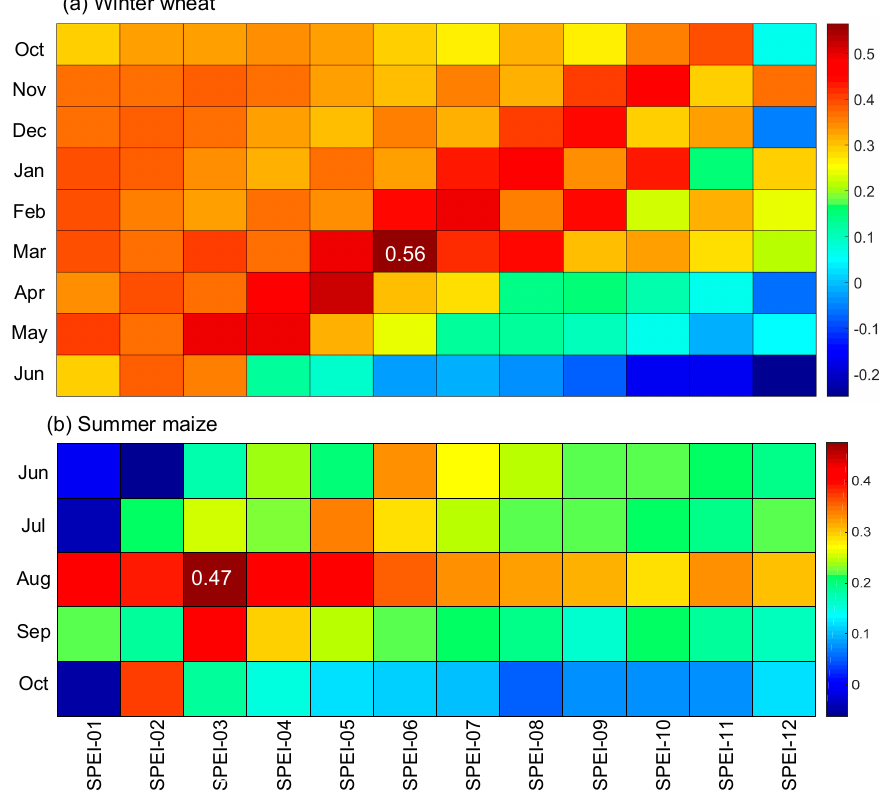
Figure 6. Spearman’s correlation coefficients ( r) between the monthly detrended SPEI during 1- to 12-month lags and the SYRS of winter wheat ( a ) and summer maize ( b ) from 1989 to 2016. The number marked with the white font denotes the maximum correlation between the detrended SPEI and SYRS of winter wheat or summer maize.